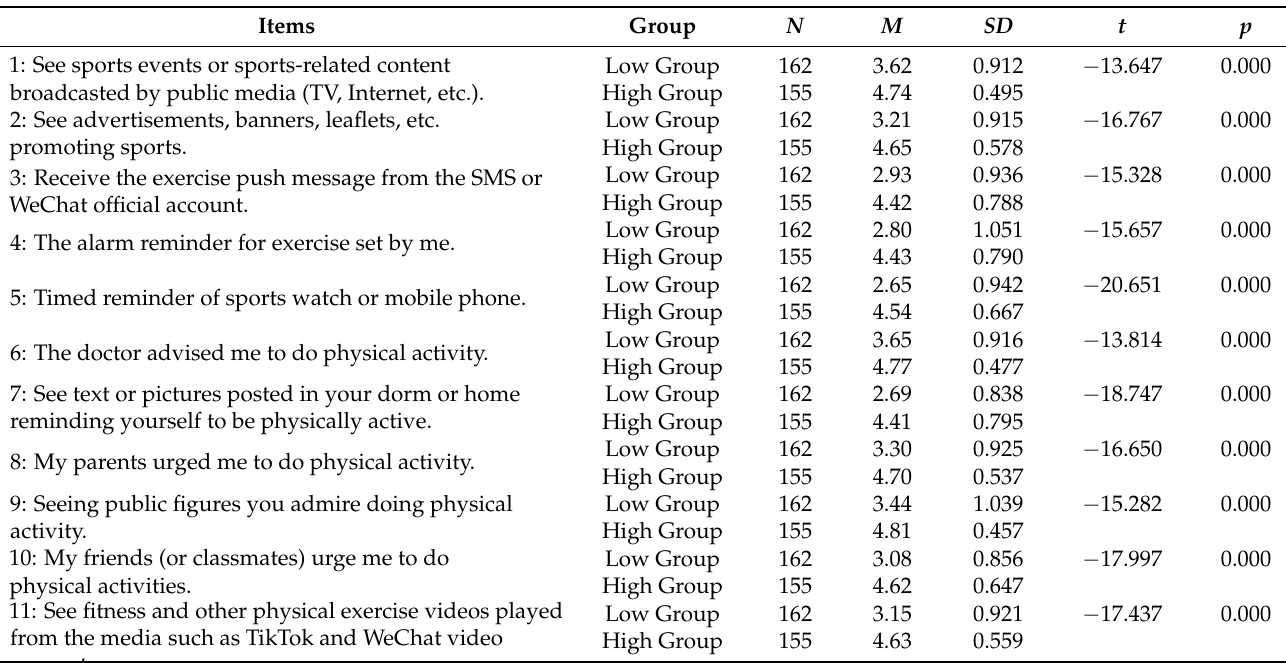
Table 1. Mean Differences between High and Low Groups ( N =